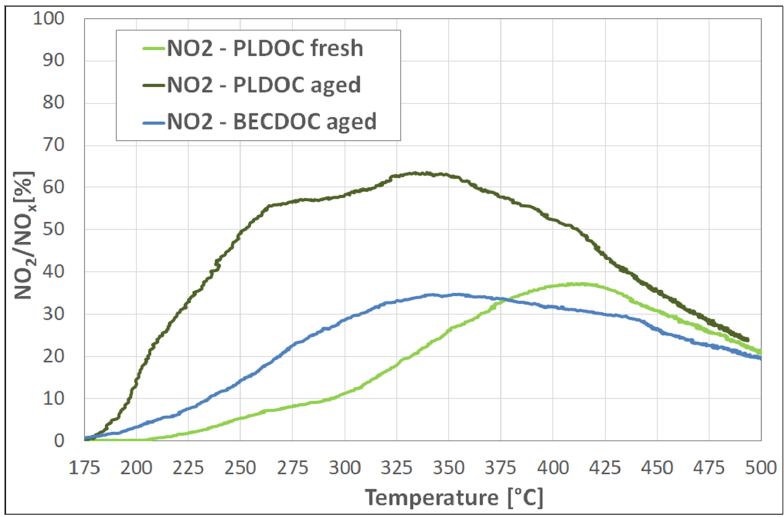
Figure 13. DOC: NO → NO 2 oxidation.